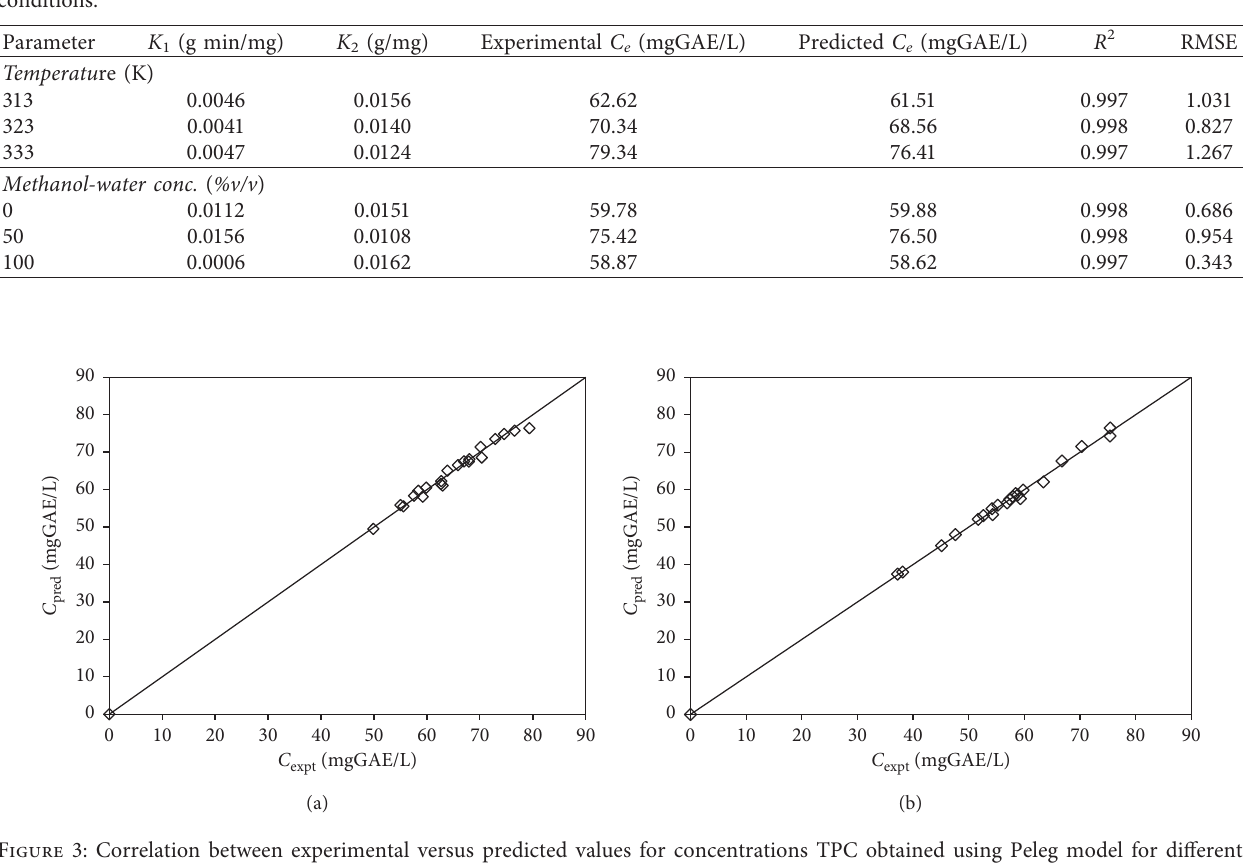
Table 1: Kinetic parameters for Peleg model and experimental and predicted equilibrium concentration values at different extraction